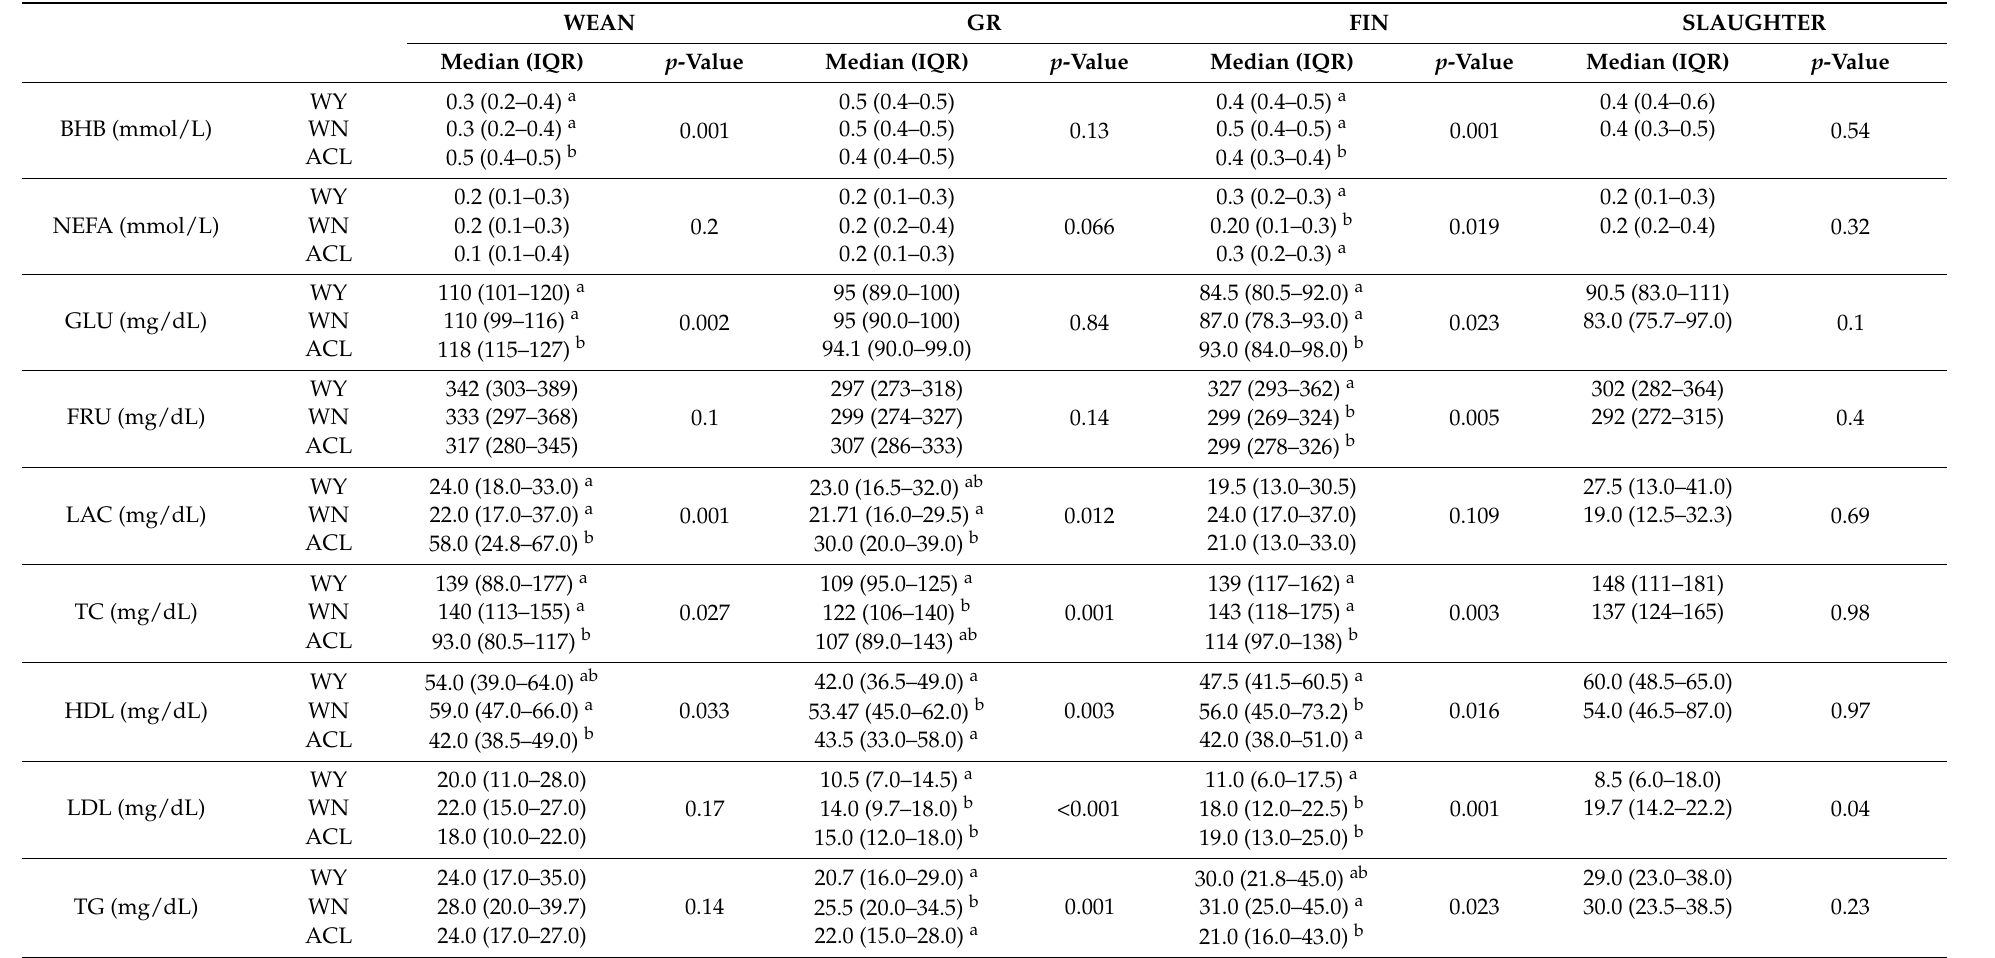
Table 6. Transversal approach of metabolic parameters of steers at four time points during the fattening period and before